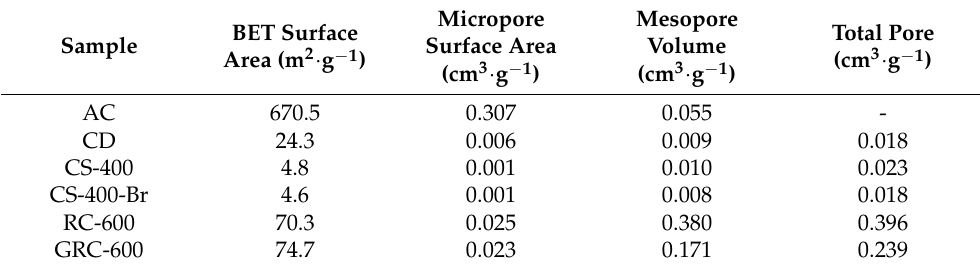
Table 3. Parameters of porous structure for LCOA.